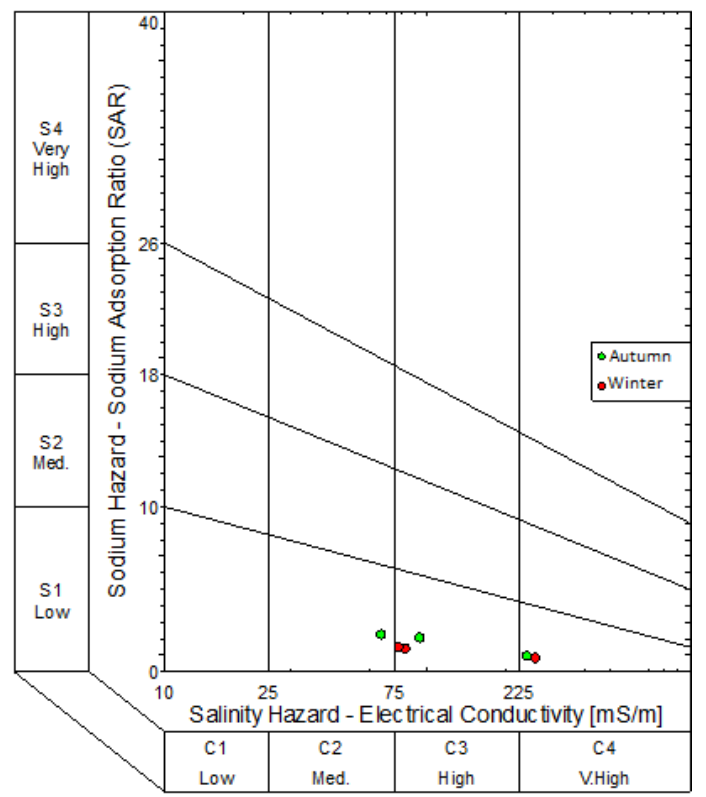
Figure 8. SAR diagram for the boreholes in the southern landfill site .